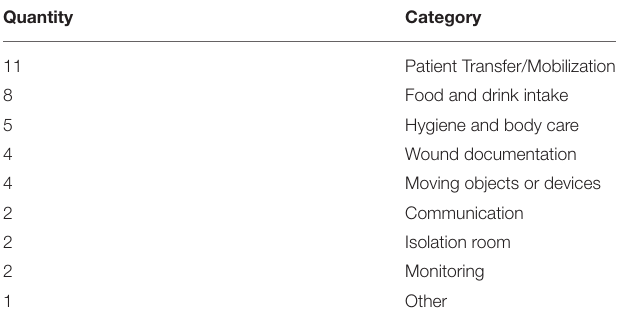
TABLE 2 | Qualitative evaluation of the question: “Can you imagine further meaningful application possibilities of the technology in nursing?” Quantity